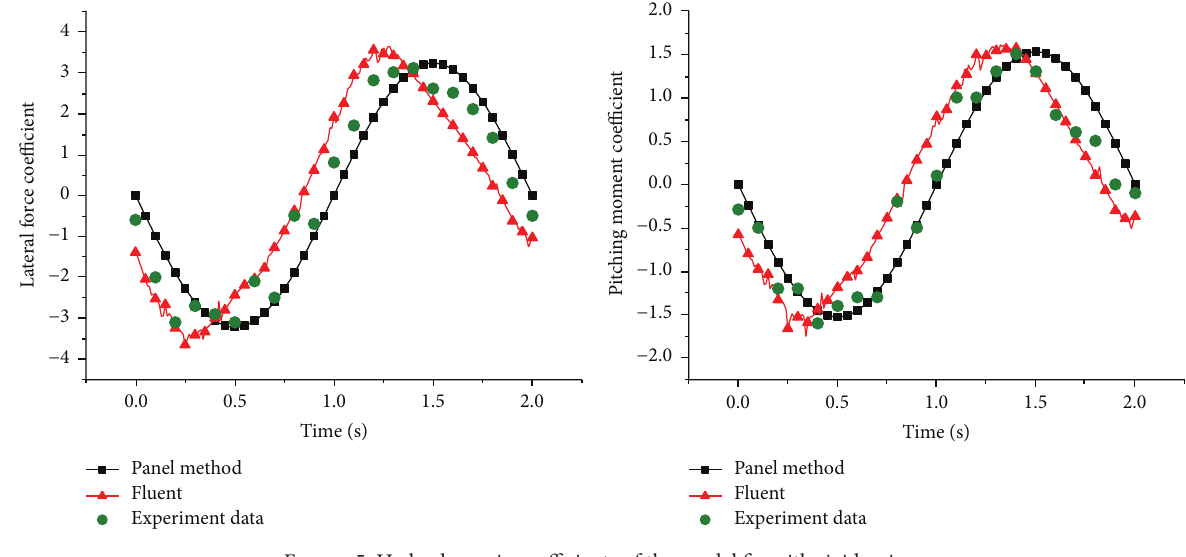
Figure 5: Hydrodynamic coefficients of the caudal fin with rigid swing.